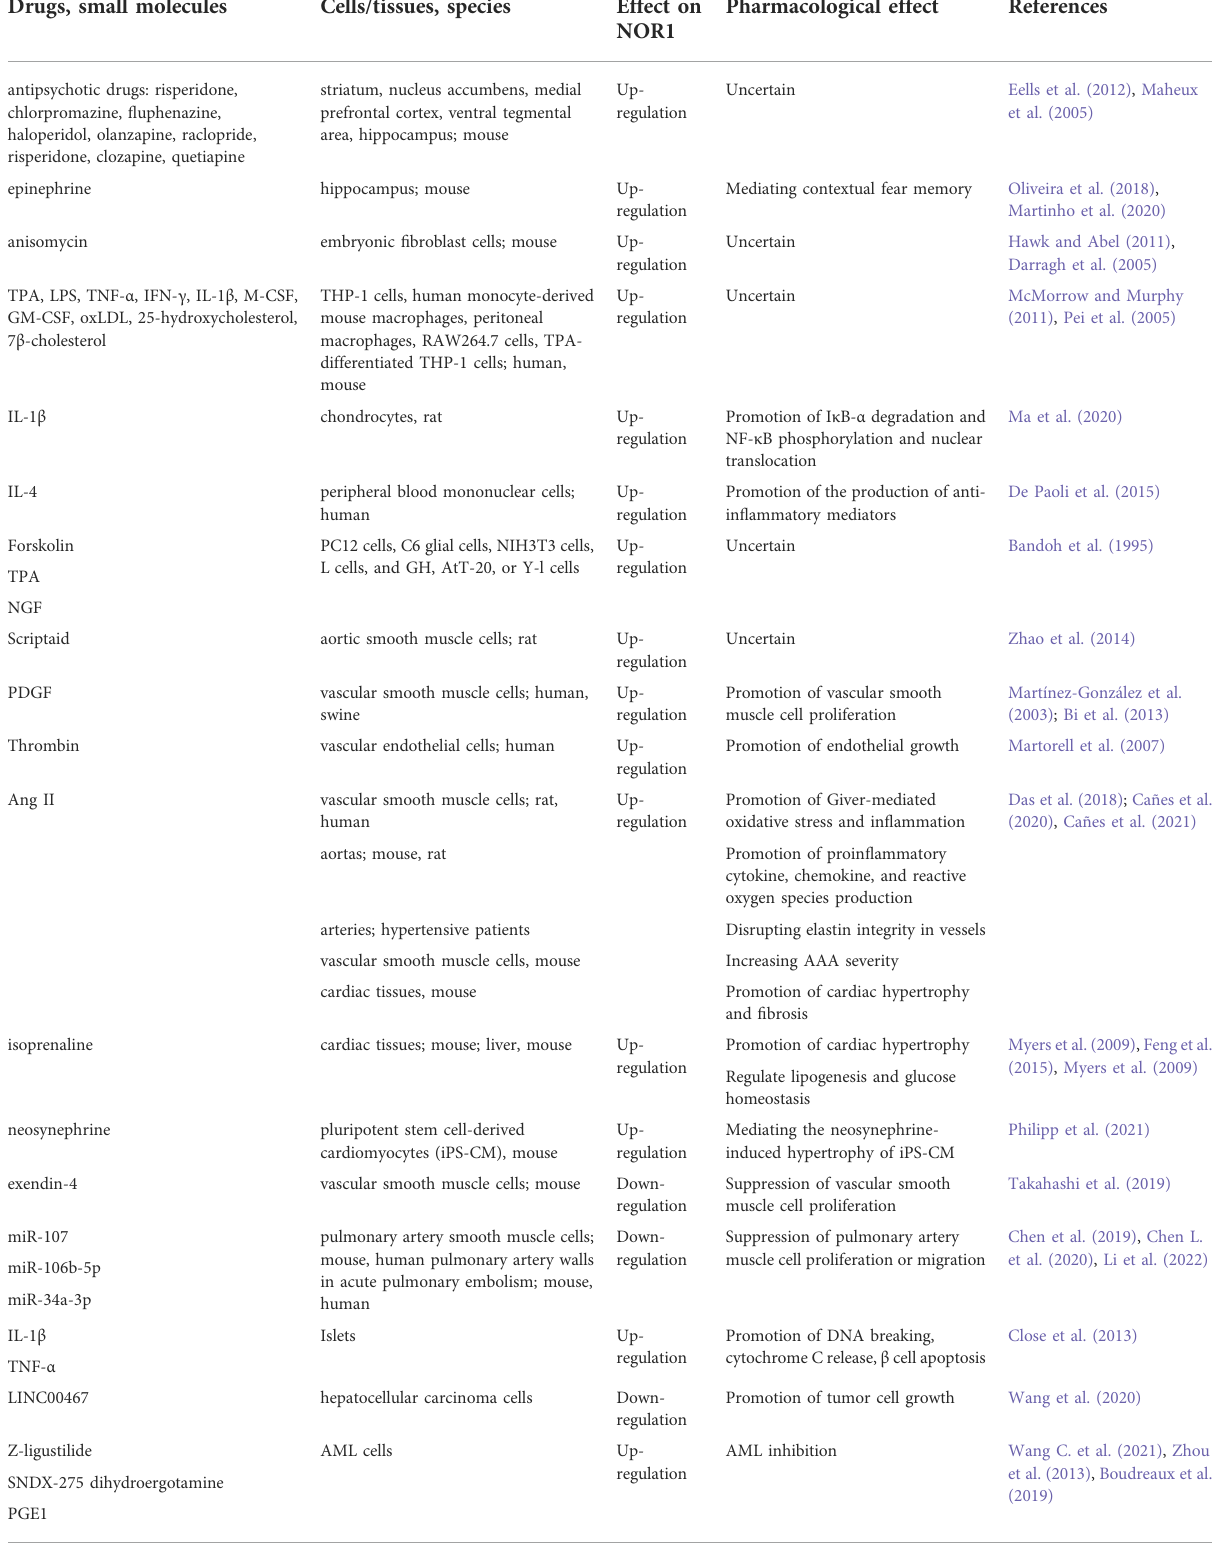
TABLE 1 A summary of drugs or small molecules that can regulate NOR1 expression in various types of cells and tissues. Drugs, small